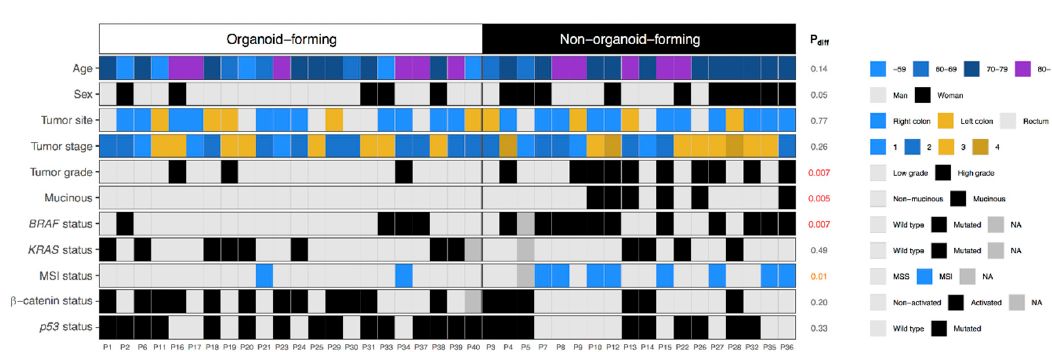
Figure 2. Establishment of organoid cultures in relation to the clinicopathological characteristics of their matching primary tumors. Comparison of the molecular background of organoid-forming tumors and non-organoid-forming tumors. and non-organoid-forming